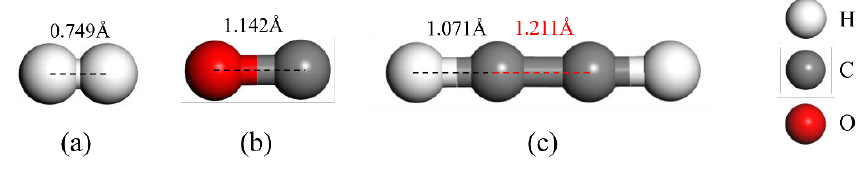
Figure 1. Structures of ( a ) H 2 , ( b ) CO, and ( c ) C 2 H